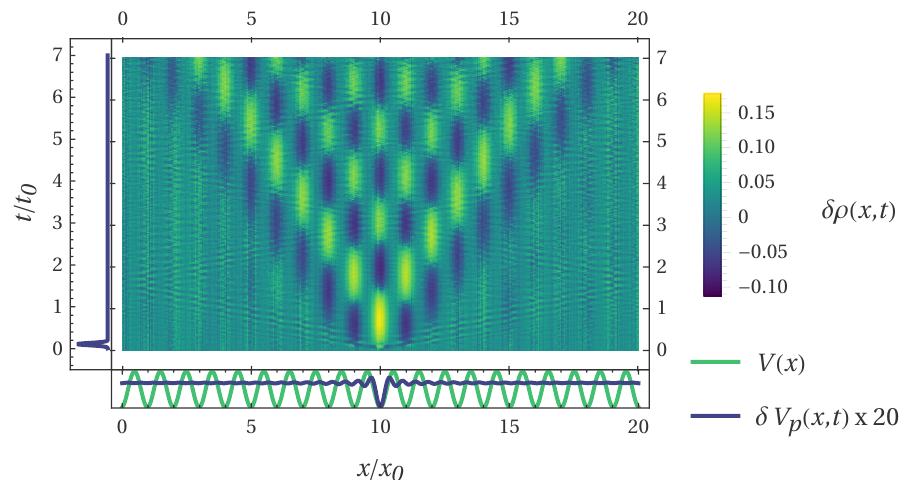
Figure 1: Spatial density fluctuation δρ ( x , t ) = ρ ( x , t ) − ρ ( x ,0 ) evolving in time, from which we obtain S ( k , ω ) . Initially the system is in the ground state (obtained via i-tVMC) of the optical potential V ( x ) (green line). At time t = 0, a weak pertur- ( x , t ) with a Gaussian time profile (blue line along vertical axis) and bation pulse δ V p a superposition of various momentum modes (blue line along horizontal axis), given by equation (8), is turned on. The main color map shows the propagation in time (vertical) and space (horizontal axis) of the density fluctuation δρ induced by the perturbation. The amplitude of the pulse δ V is magnified by a factor of 20. The sys- p = 7 E / k tem parameters V , g = 0.41 E (corresponding to U / J = 6) and the pulse r r L 0 = 0.0125 E = 0.1 t parameters V , t and τ = 0.04 t are used in this e r e 0 0